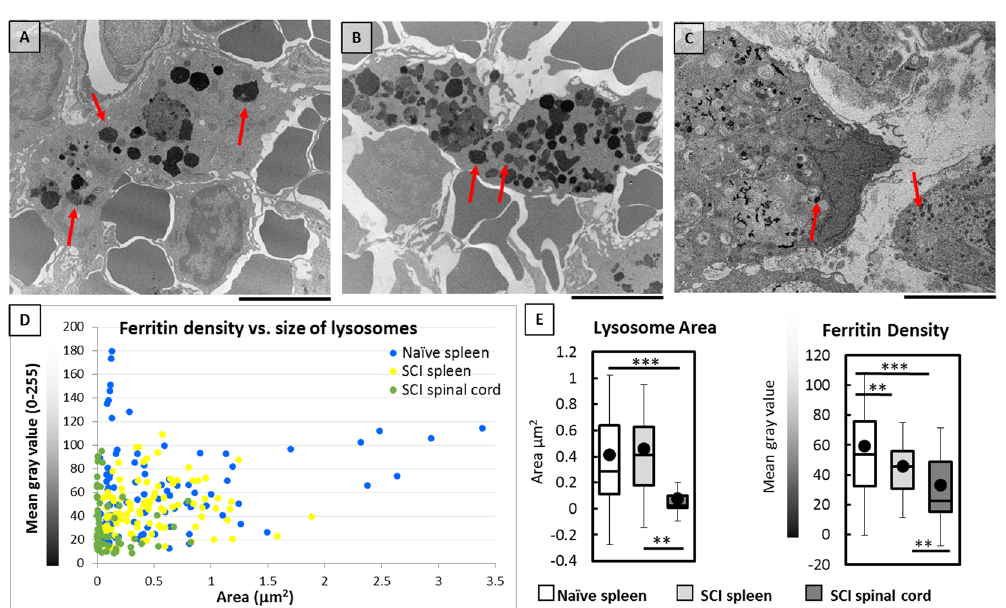
Figure 5. Ultrastructural characterization of the size and density of lysosomes containing ferritin(iron) (denoted by red arrows) in macrophages using TEM imaging of ( A ) naïve spleen, (B) SCI spleen, and ( C ) SCI spinal cord. Scale bar is 5 µ m. ( D ) Scatter plot of ferritin(iron) density vs. lysosomal area, ( E ) box plots indicating lysosome area and ferritin(iron) density for each sample type. Low values of pixel gray values correspond to high ferritin(iron) density. ‘ ** ’ And ‘ *** ’ Indicate p-value < 0.01 and 0.001